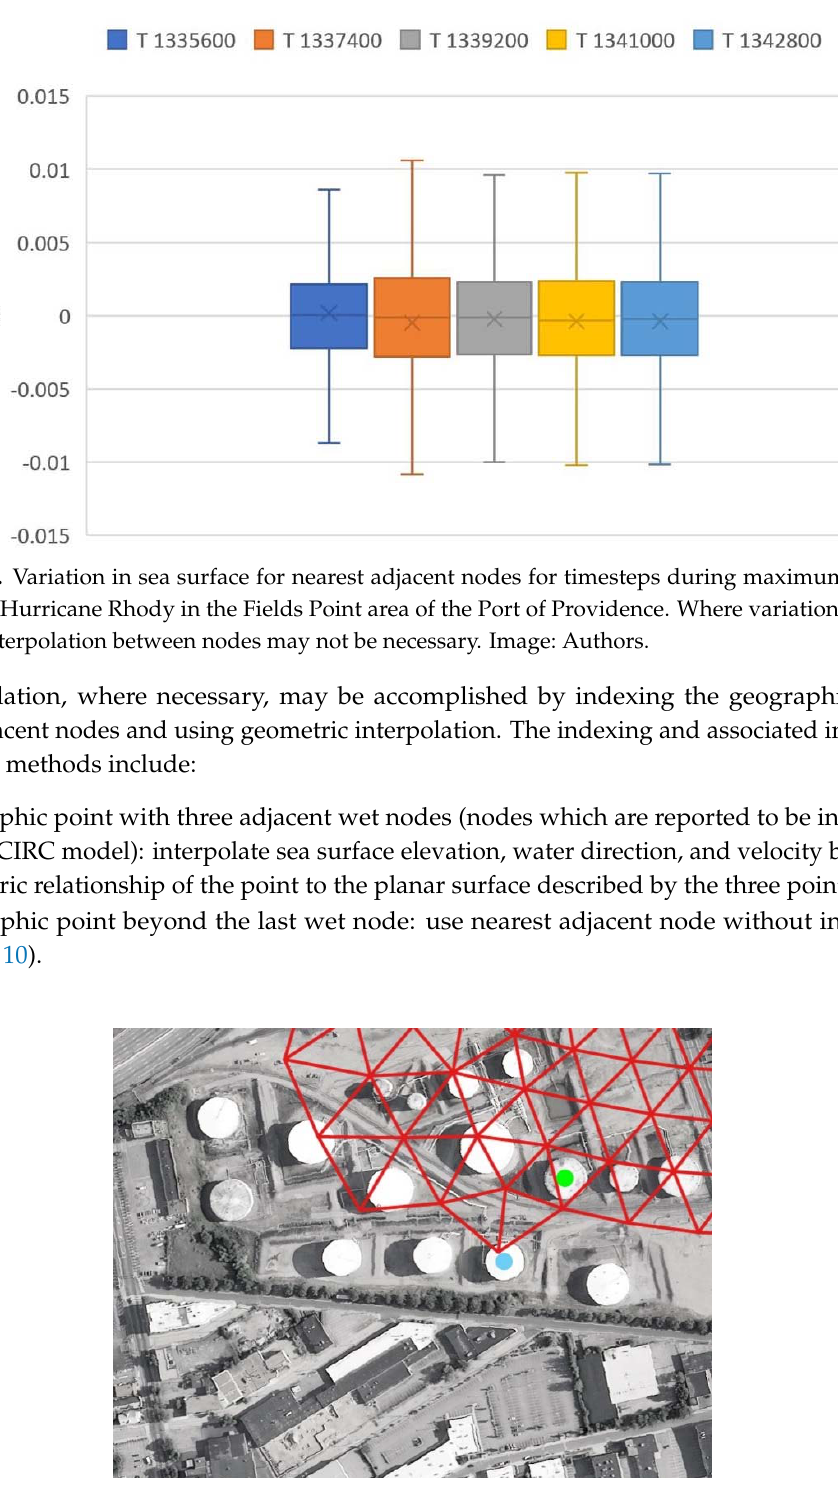
Figure 10. Example of a point with three adjacent nodes ( green ) and point beyond the nearest wet node ( blue ). The red lines represent wet portions of the unstructured ADvanced CIRCulation model (ADCIRC) grid. Points tested are both inside and outside of the grid, and constrained by a basin analysis. Image: Authors (Air photo: Rhode Island Geographic Information System (RIGIS)).